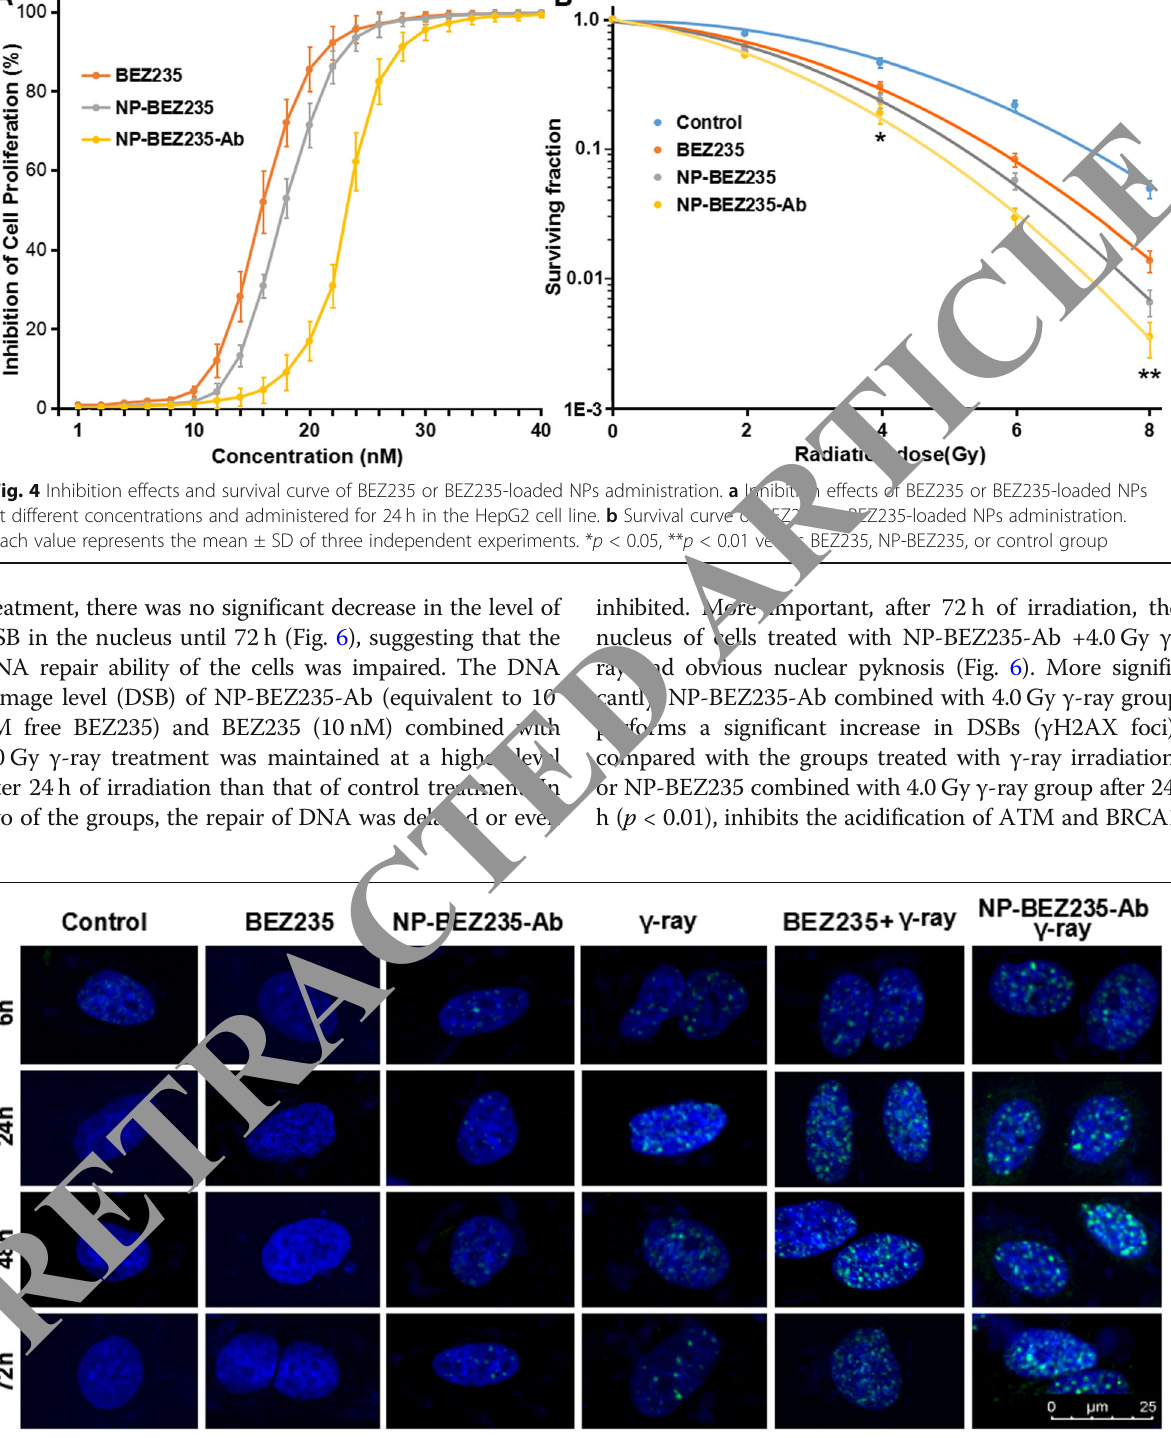
Fig. 5 BEZ235 and NP-BEZ235-Ab enhance low-dose γ -ray-induced DNA fragmentation and inhibit the repair of damaged DNA. Immunofluorescence staining for γ H2AX phosphorylation (DSB) in HepG2 cells after γ -ray or in combination with BEZ235 or NP-BEZ235-Ab. There was almost no DSB in the control group or BEZ235 group. However, the number of DSB in the nucleus increased after γ -ray irradiation, and the DSB level in the BEZ235 or NP-BEZ235-Ab combined γ -ray irradiation group were significantly higher than that in the single γ -ray group, suggesting that BEZ235 had increased radiosensitivity. Green, γ H2AX foci; blue, 4 ′ ,6-diamidino-2-phenylindole